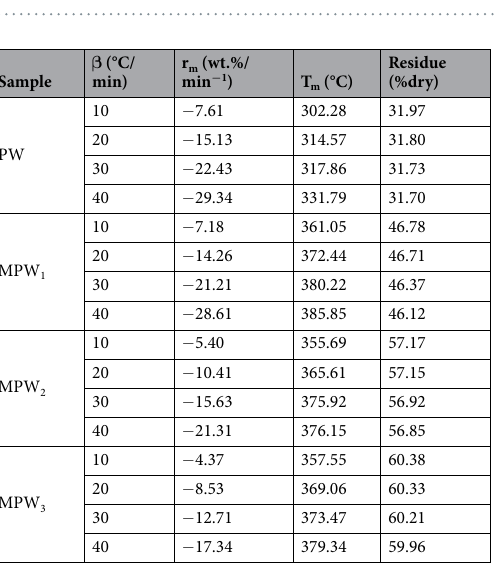
Figure 4. TG and DTG curves of ( a ) PW, ( b ) MPW 1 , ( c ) MPW 2 and ( d ) MPW 3 with heating rates of 10, 20, 30 and 40 °C/min in nitrogen atmosphere.